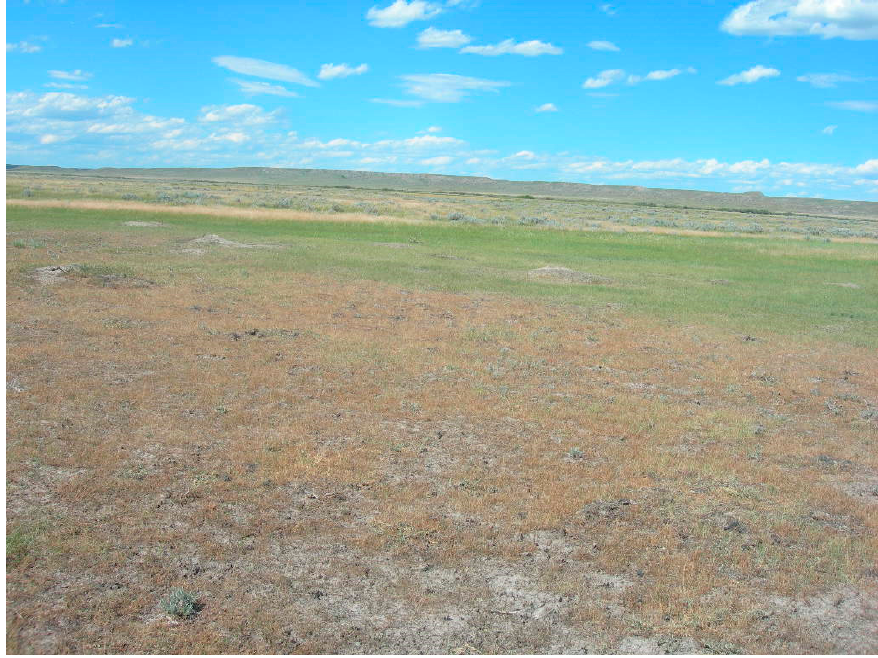
Figure 1. A typical mixed grassland scene with exposed soil, photosynthetic grass, and non- photosynthetic